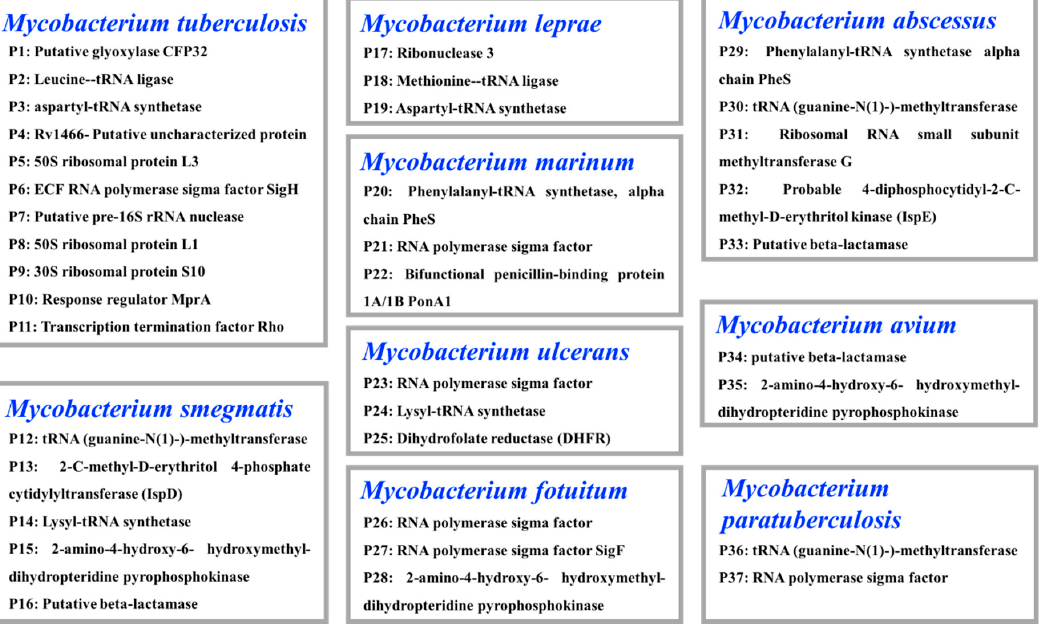
Figure 6. List of the collection of 37 TB proteins from nine Mycobacteria species.